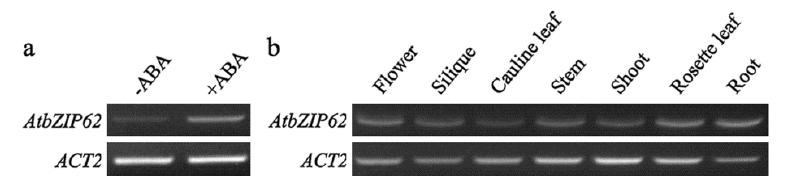
Figure 1. Expression of AtbZIP62 in response to ABA treatment and in different tissues and organs. ( a ) Expression of AtbZIP62 in response to ABA treatment. Col wild-type seedlings of10-day-old were treated for 4 h with 50 µ M ABA, RNA was isolated and used for RT-PCR to examine the expression of AtbZIP62 . ACT2 was used as a control for RT-PCR. ( b ) Expression pattern of AtbZIP62 . Different tissues and organs were collected from the Col wild-type Arabidopsis plants. RNA was isolated and used for RT-PCR to examine the expression of AtbZIP62 . ACT2 was used as a control gene for RT-PCR.